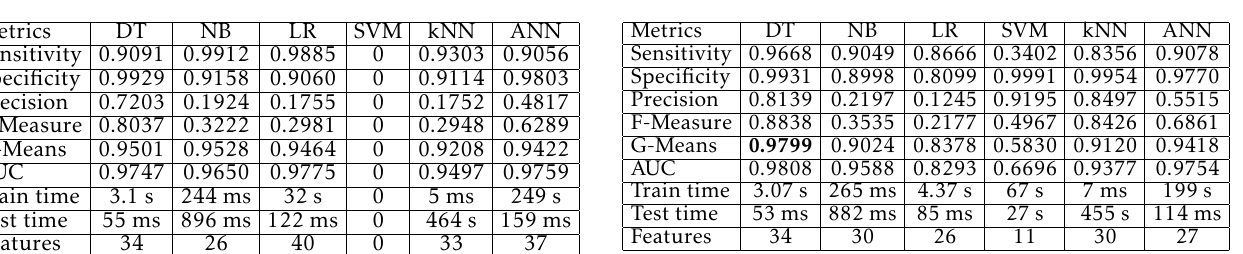
Table 8. Results of using GR-BFE algorithm on SHELLCODE.